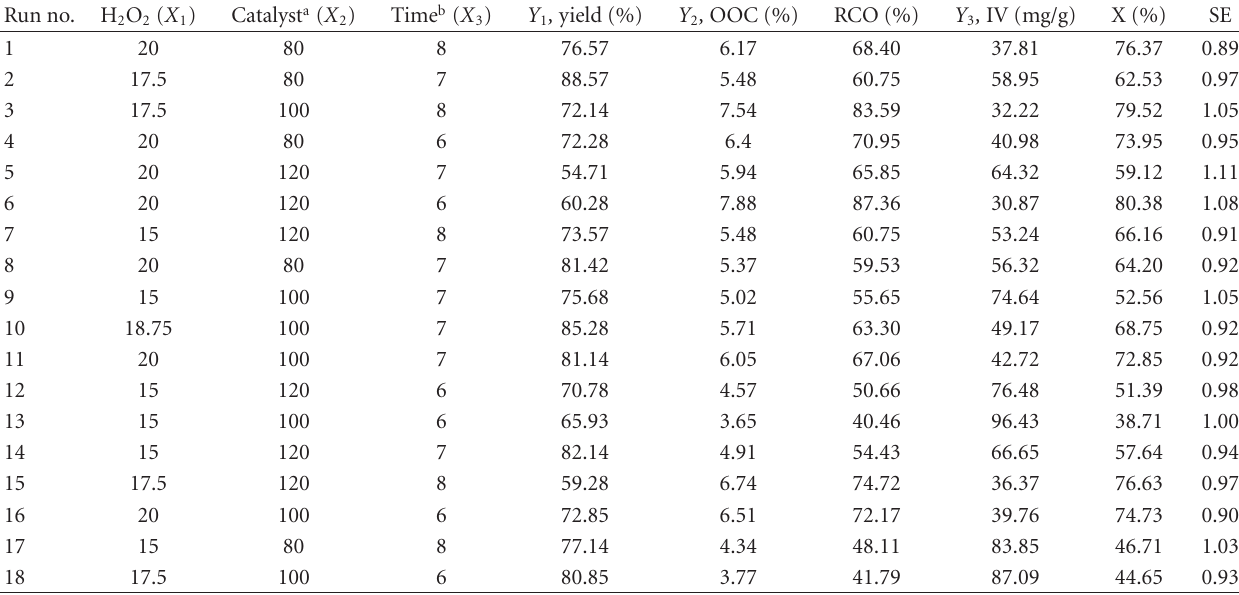
Table 2: D-optimal design arrangement and responses for